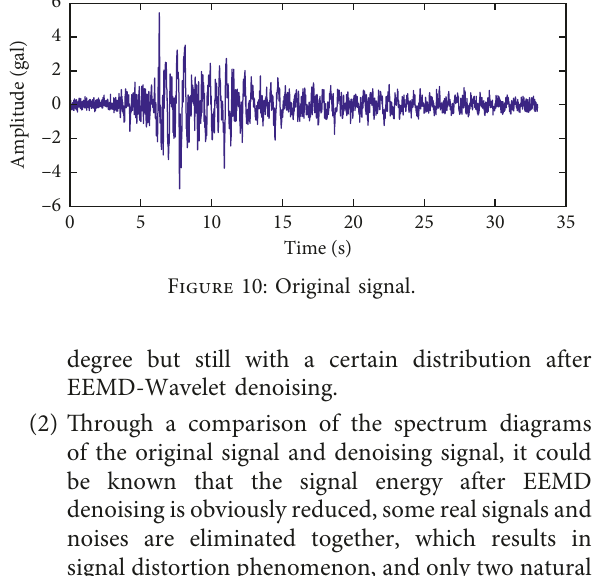
Figure 13: EEMD-Wavelet-SSA denoising